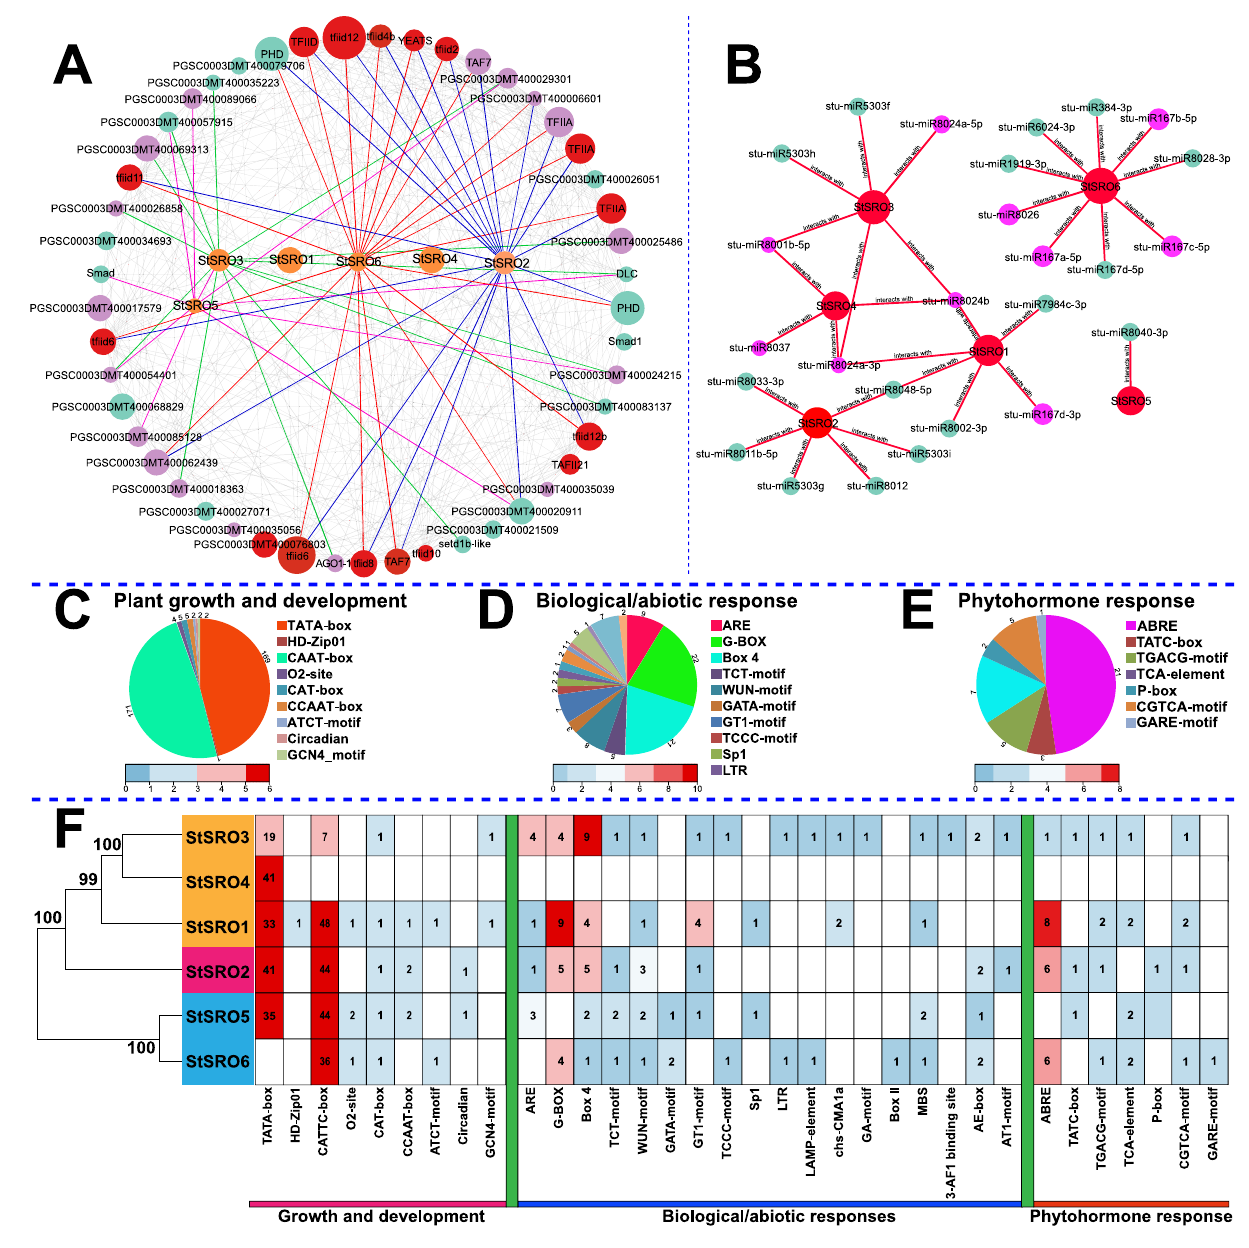
Figure 6. Interaction network diagram of StSROs and motif analysis and prediction of cis-acting elements of promoter. ( A ) Network analysis of interactions between StSROs and other proteins. Each circle represents a protein, the size of the circle represents the number of interactions between StSROs and other proteins, the connection between the two circles represents the interaction between the two; the protein of StSROs were represented by orange circles, and related proteins are represented by green circles. Transcription factors are indicated by red circles and unlabeled proteins are indicated by purple circles, as detailed in Supplementary Table S10. ( B ) Targeted interactions between StSROs and miRNAs. StSRO family members were represented by red circles, and the number of connections between each circle indicates the number of interactions. Abiotic stress-associated miRNAs were represented by purplish red circles, and biological stress-associated miRNAs are represented by green circles. ( C ) Proportion of plant growth and development. ( D ) Proportion of plant hormone responsive cis-elements. ( E ) Proportion of the number of cis-elements associated with abiotic stress. ( F ) Cis-acting elements of StSROs, as detailed in Supplementary Table S12. The diversity and evolutionary conservation of microRNAs (miRNAs) determine the importance and universality of physiological and biochemical functions [30]. Therefore, we predicted the targeted regulatory relationship between miRNAs and StSROs through